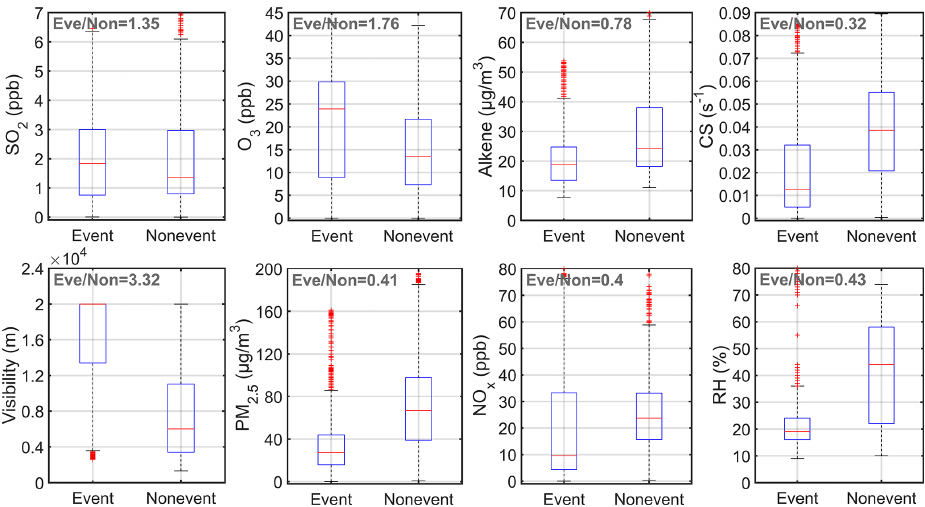
Figure 3. Boxplots for the concentrations of SO 2 , O 3 , alkenes, CS, visibility, PM 2 . 5 , NO x concentration and RH during SA event and non- event nights. In each plot, the red line is the median value, the bottom and the top blue lines are the 25 and 75 percentiles, and the whisker range covers the ± 2.7 σ of the data. Outliers are the ones out of the ± 2.7 σ range of all selected data. The dark gray values on the top-left corners are the ratios between median values of event and non-event days.